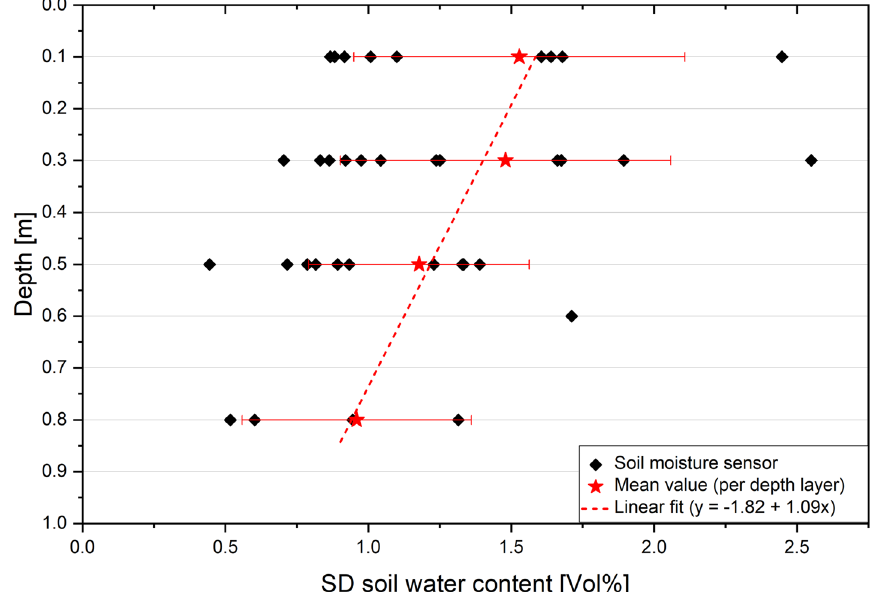
Fig. 13 Variation of soil water content with depth below surface; black squares show standard deviation of mean soil water content at different depths from all gravity stations, red stars mark mean SD for each depth layer, linear fit of SD mean values (red dashed line) reveals depth of zero soil water content variation at y 0 1.82 =